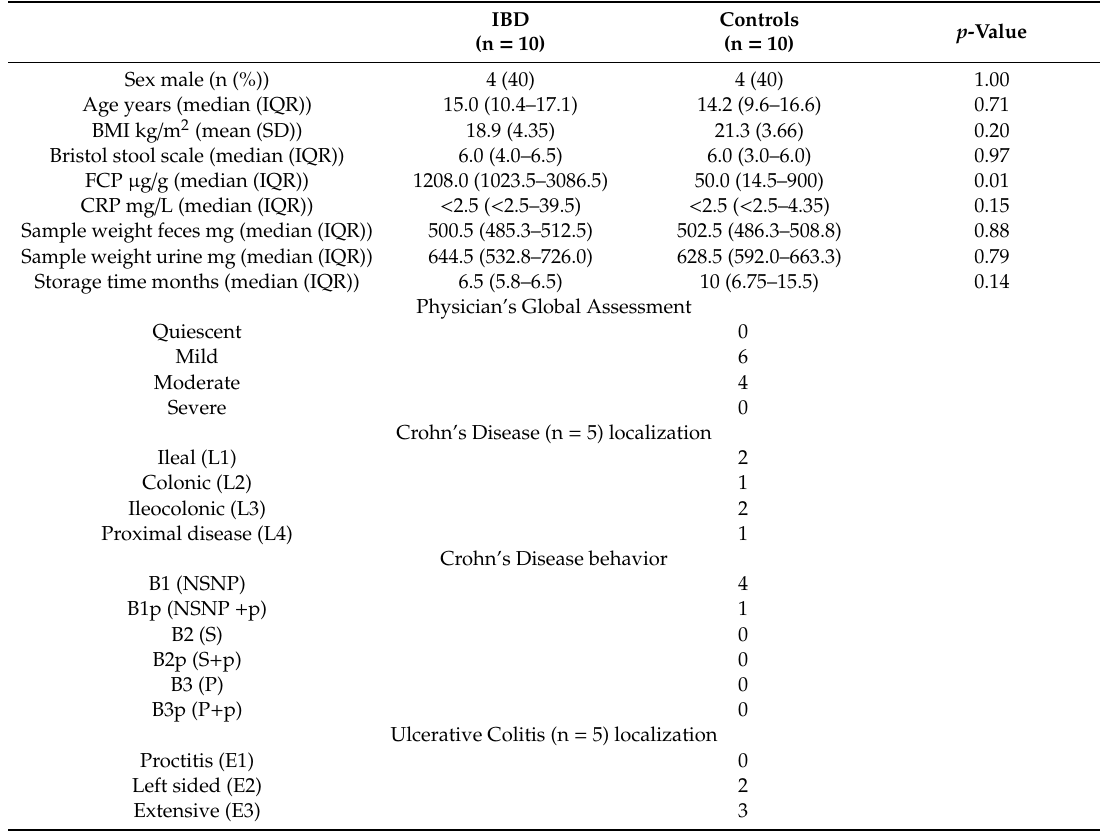
Table 1. Baseline characteristics.